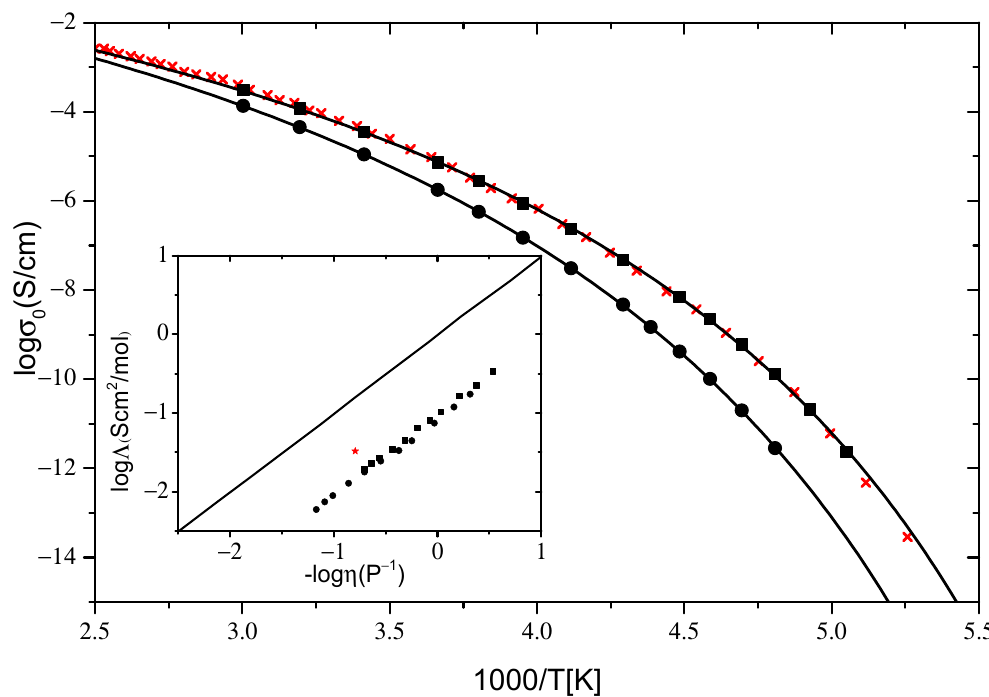
Figure 3. Arrhenius diagram of conductivity σ 0 [S/cm] for [P 8881 ]Lev (squares) and [N 8881 ]Lev (circles) IL systems. The solid lines are VFT fits to the data. The red crosses are reproduced data from [25] for conductivity of [N 8881 ]NTf 2 IL system. The inset shows a Walden plot for the systems under investigation and the [N 8881 ]NTf 2 IL system (red star) along with the “ideal” Walden line (KCl aqueous solution).